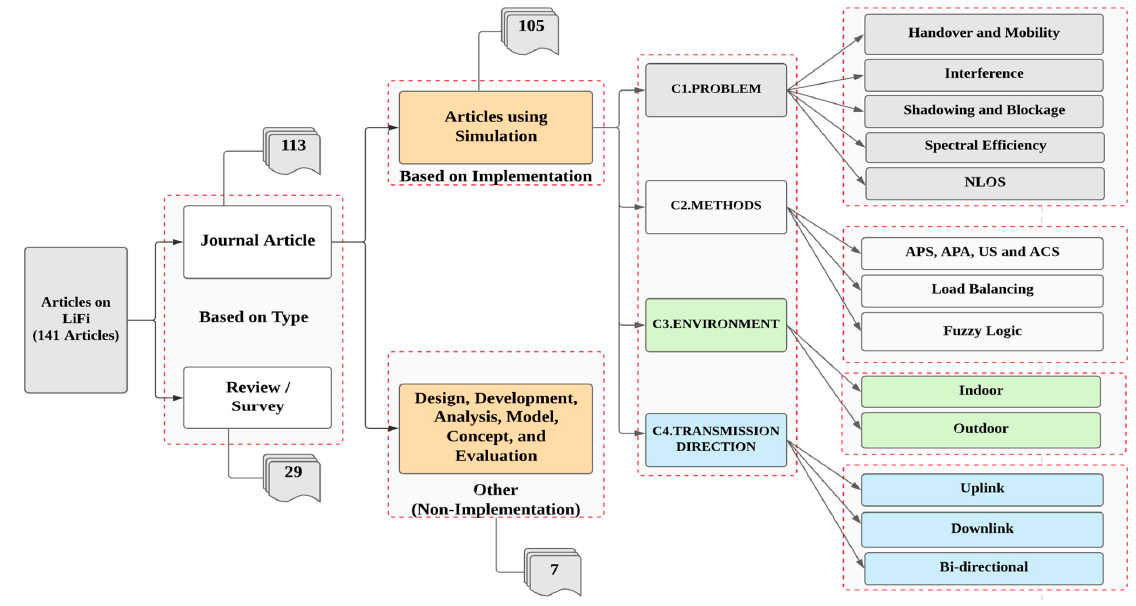
Figure 4. Taxonomy of literature on LiFi.